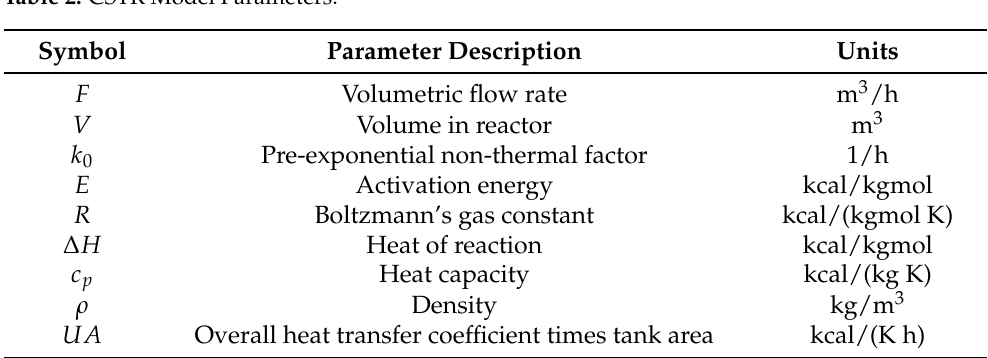
Table 2. CSTR Model Parameters.